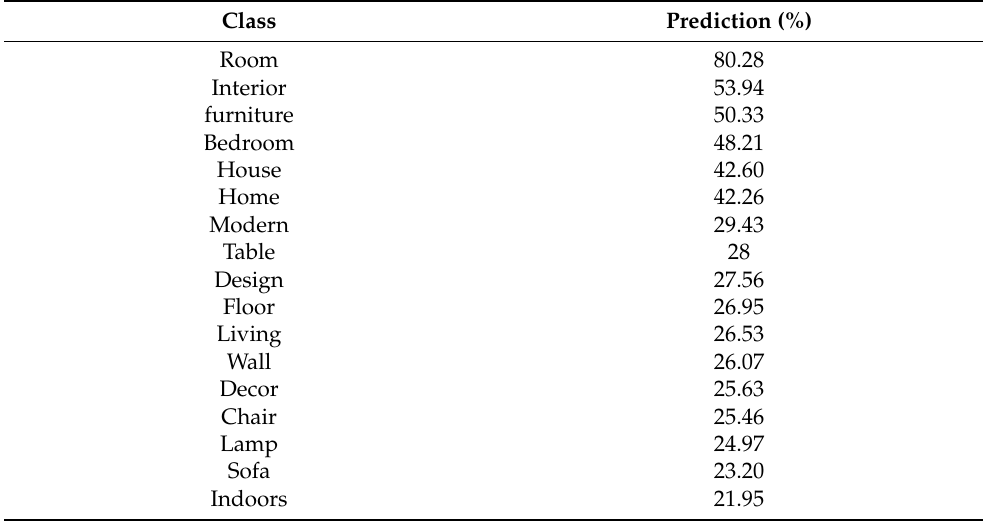
Table 5. Prediction results of a band extracted from a cubemap generated by the approach of the present